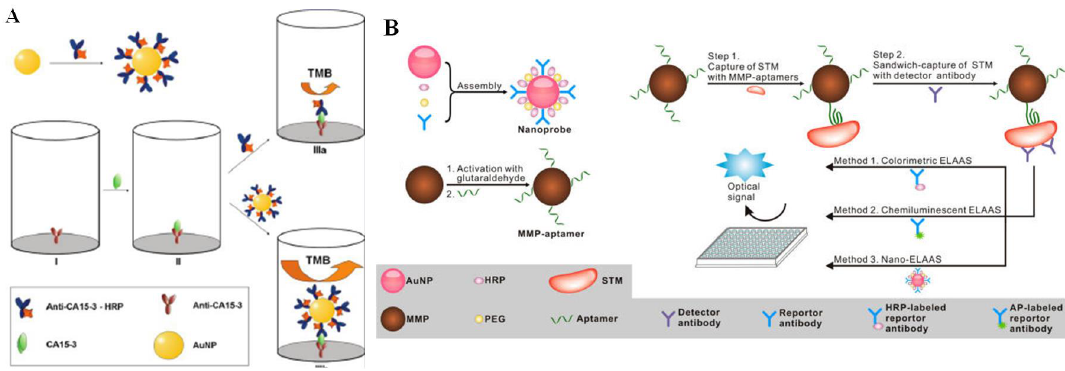
Figure 14. ( A ) Schematic (not in scale) of the preparation of the complex Au-anti-CA15-3-HRP and the sandwich-type ELISA procedure without (IIIa) and with (IIIb) the application of AuNPs as the signal enhancer. Reproduced with permission from [153]. Copyright American Chemical Society, 2010. ( B ) Schematic illustration of serovar Typhimurium (STM) detection based on HRP and detection antibody-modified AuNPs. Reproduced with permission from [155]. Copyright American Chemical Society,